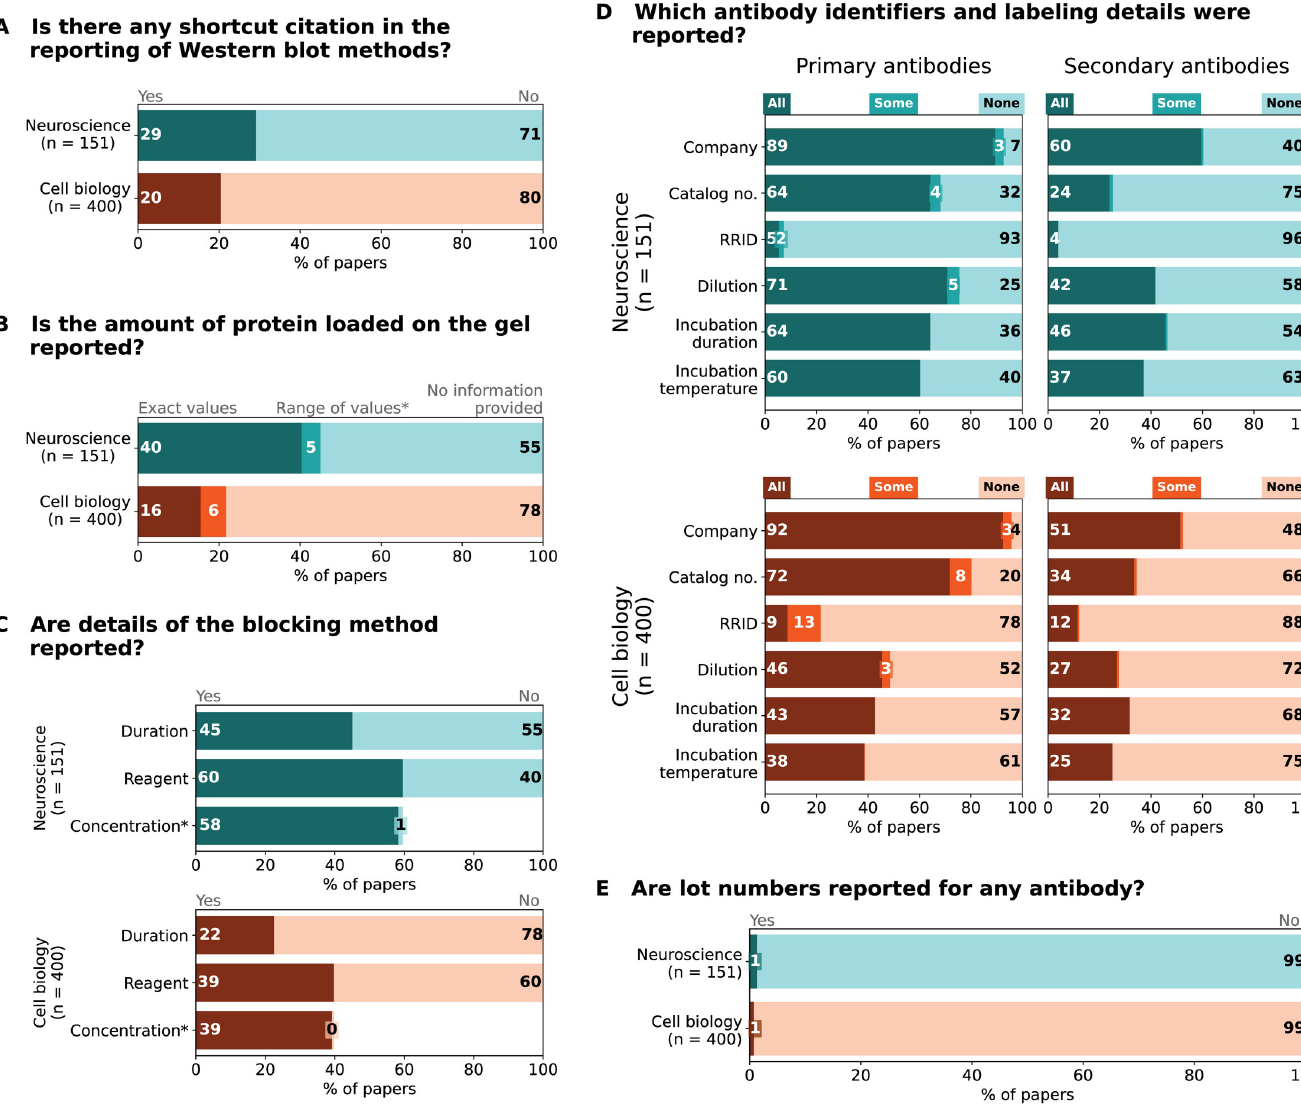
Fig 4. Western blot methods reporting: Frequency and quality of reporting for selected methods reporting items. Bar graphs illustrate (A) the use of shortcut citations and the reporting of (B) total protein amount used for blotting. � Fewer than 0.5% of papers reported both exact values and ranges of values; therefore, this category was combined with “Range of values”. (C) Blocking step. � Categories All and Some were combined because Some was < 1%. (D) Antibody identifiers and labelling protocol. (E) Lot numbers for antibodies. Totals may not be exactly 100% due to rounding. Labels that annotate < 2% are not shown. The data underlying this figure can be found at https://osf.io/2c4wq/ [24].